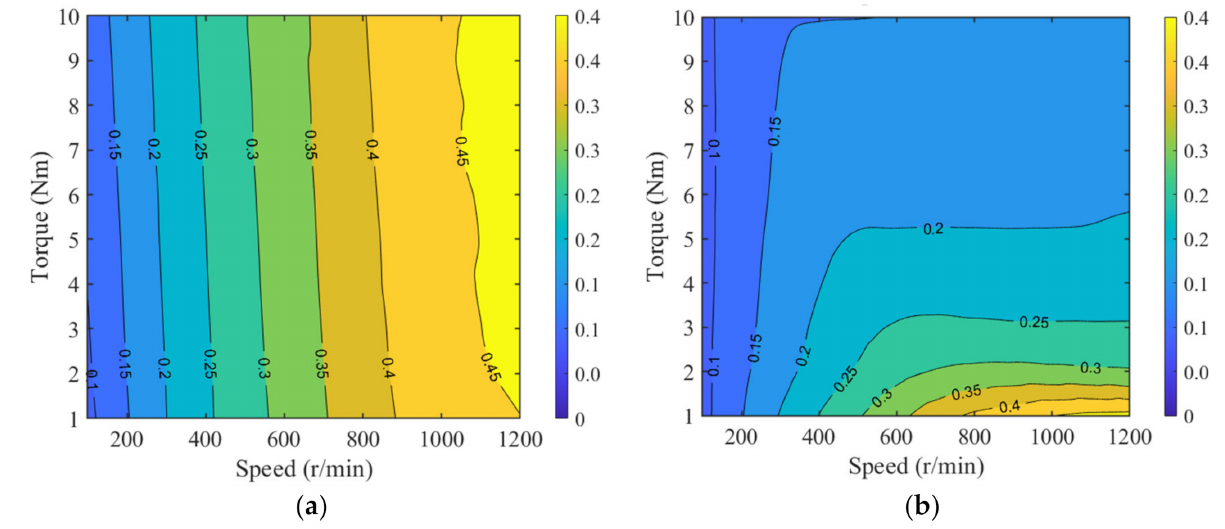
Figure 10. The electromagnetic torque standard deviation: ( a ) SMC system with the FPRL; ( b ) SMC system with the